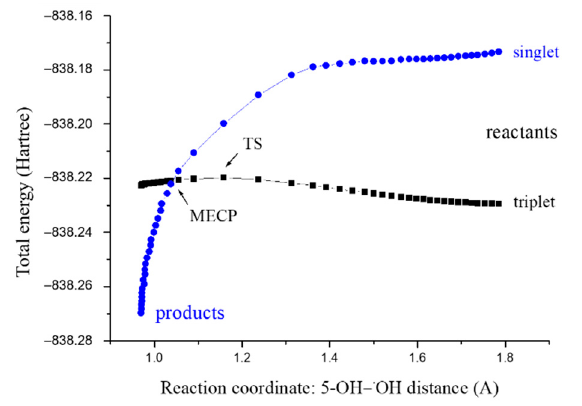
Figure 4. Energy profiles for the PCET pathways of the 5-OH site of phenoxyl radical of 5-hydroxyferulic acid with • OH radicals in the singlet (blue line) and triplet (black line) states.